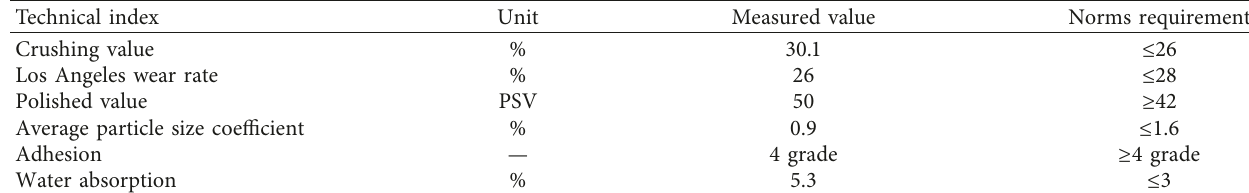
Table 1: The physical properties of CE.